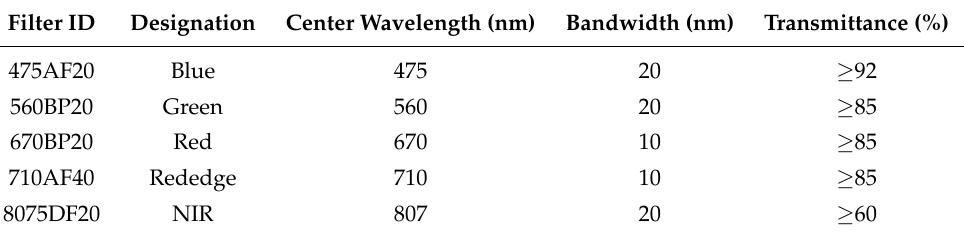
Table 3. Omegafilters bandpass filters implemented in the